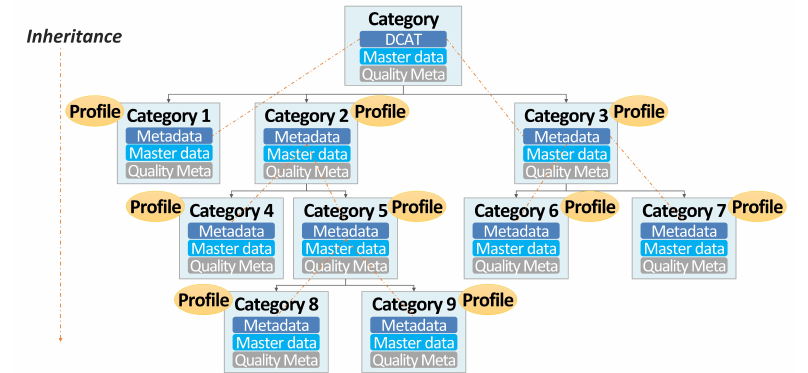
Figure 3. An example of DCATv2-based profile